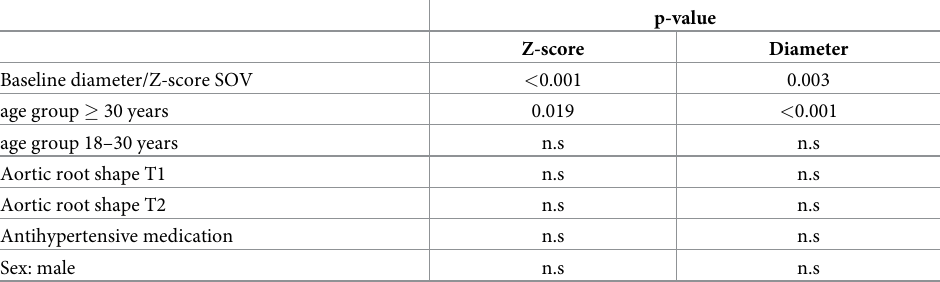
Table 2. Results of multivariate analyses predicting growth rate at the sinuses of Valsalva (SOV).